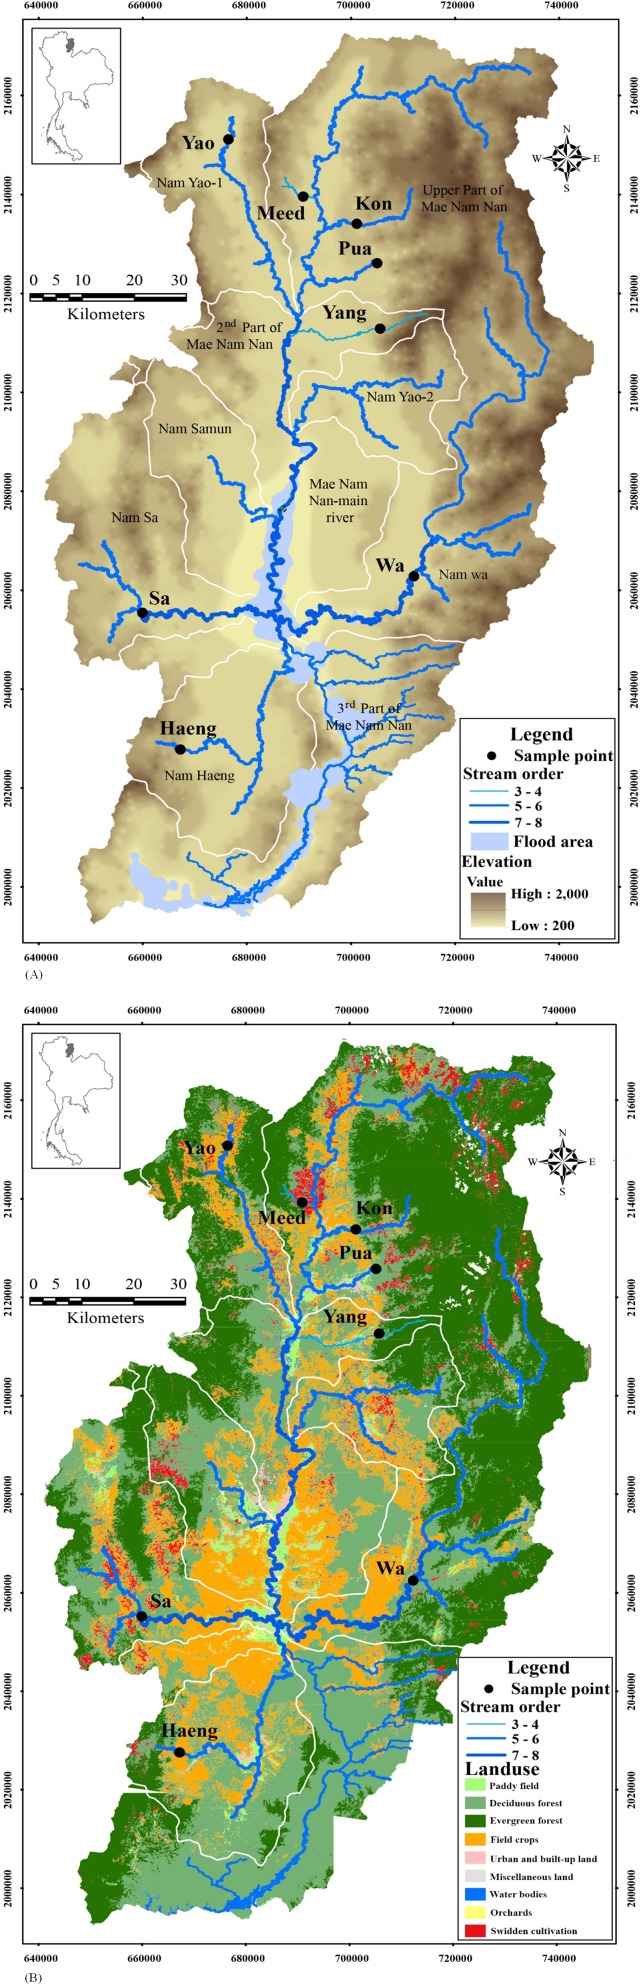
Locations of population samples of Garra cambodgiensis in the upper Nan River drainage basin, Thailand taken from November–December 2016.The map also illustrates (A) stream orders, flooded areas and elevation and (B) land use types in the drainage basin. GIS data provided by the Nan Provincial Administrative Organization.